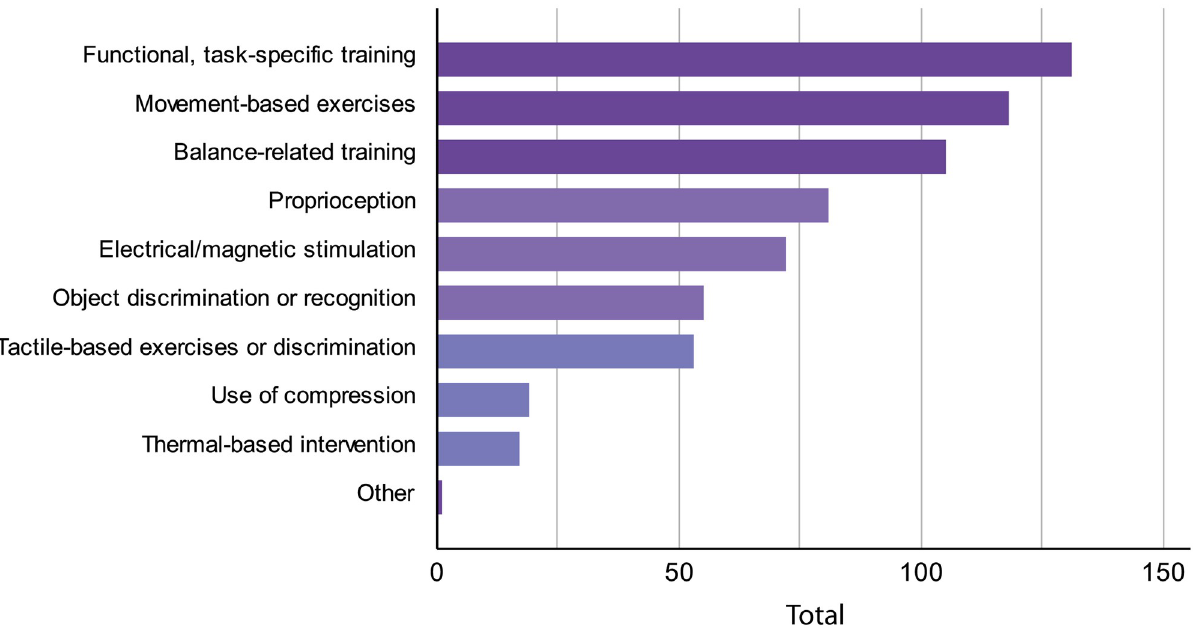
Fig 1. Different forms of somatosensory-related intervention used in clinics. The number of responses did not always sum to 132 as participants were allowed to select multiple answers.